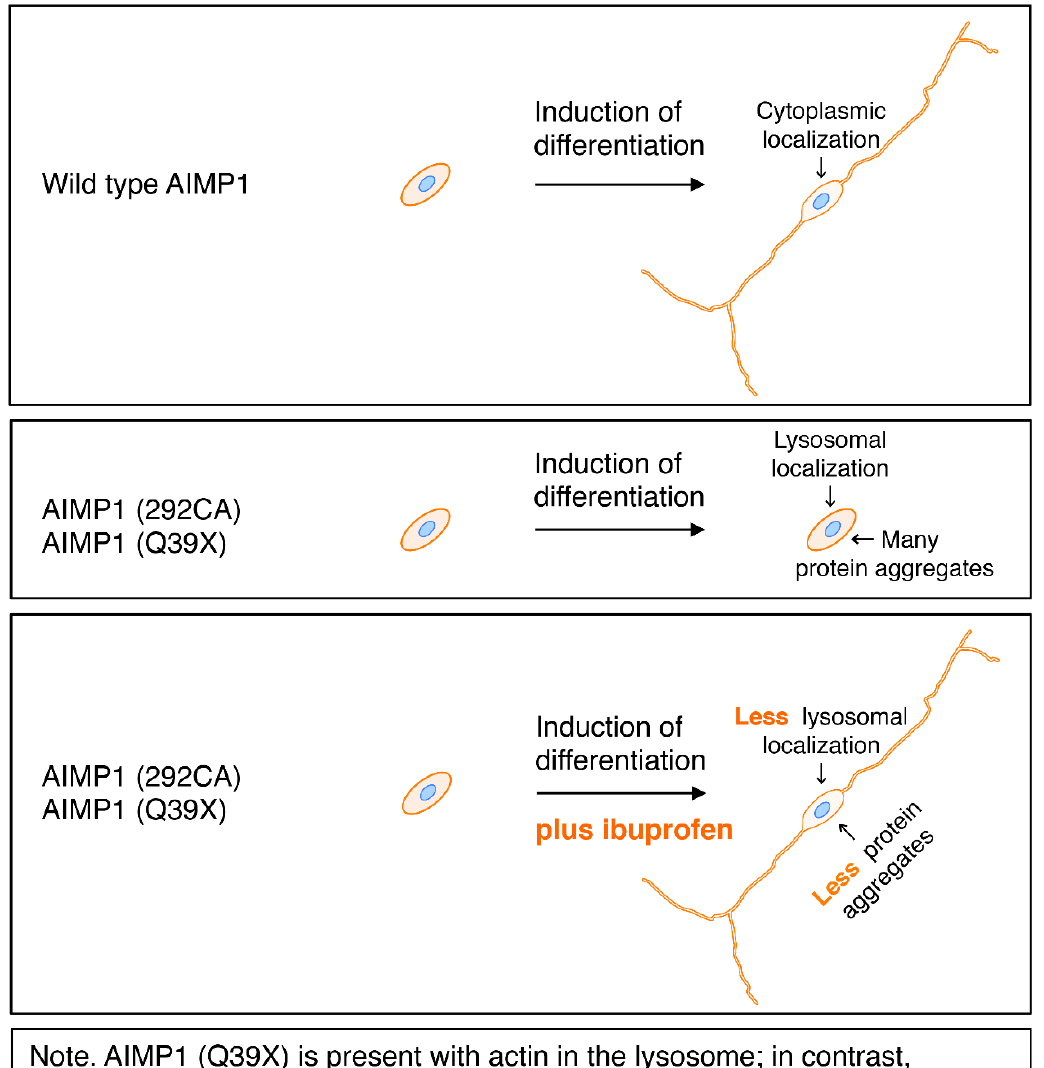
Figure 14. Schematic diagram of effects of HLD3-associated mutants on cell morphological changes in N1E-115 cells.